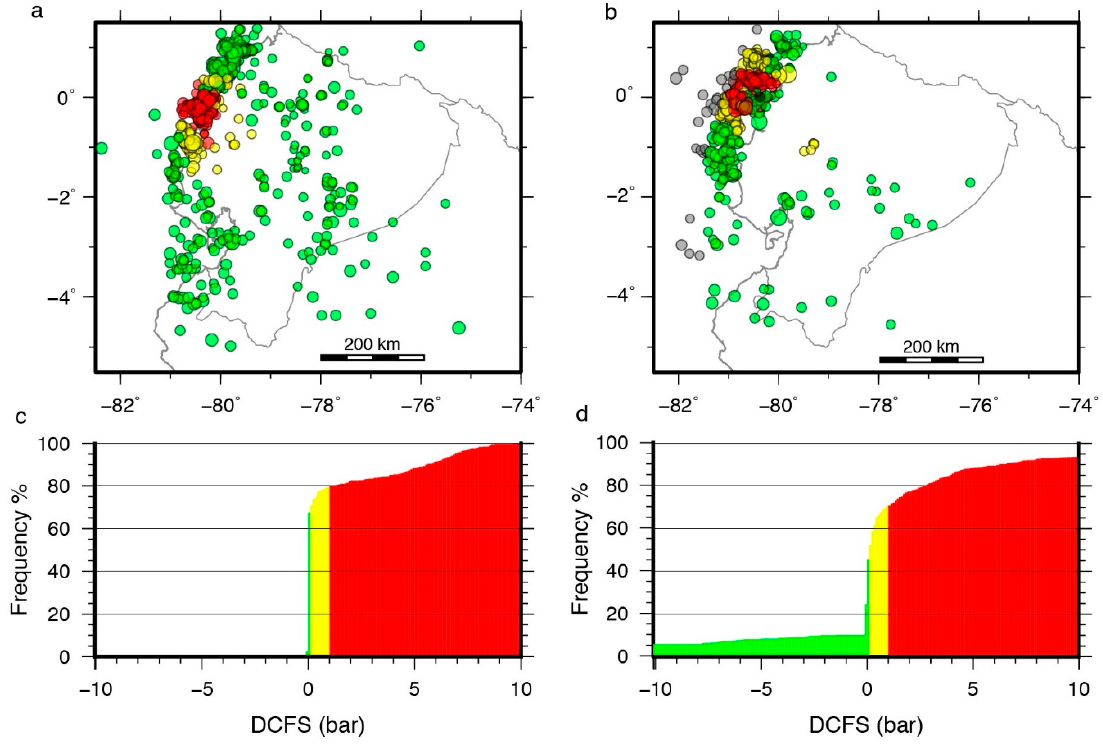
Figure 11. ( a ) Coloured circles represent seismic events in the period 16/04/2016–18/02/2018 from Instituto Geofísico Escuela Politécnica Nacional filtered for continental faults (distance to slab >10 km and depth <15 km). Colours correspond to the traffic light colour code used in Figures 7 and 8: red circles represent seismic events located in areas with a high level of potential activation ( ∆ CFS > 1 bar), yellow circles represent seismic events in medium level of potential activation (0.1 bar ≤ ∆ CFS ≤ 1), and green circles represent seismic events in areas with a low level of potential activation ( ∆ CFS < 0.1 bar; ( b ) Seismic events in the period 16/04/2016–18/02/2018 filtered for the subduction interface (distance to slab ≤ 10 km). Colours correspond to the traffic light colour code used in ( a ); ( c , d ) are the accumulated histograms of frequency (%) of seismic events after the mainshock on areas with the correspondent computed Coulomb Stress change for the continental faults ( b ) and the subduction interface ( c ). The colour of the bar indicates the level of potential activation on a traffic light colour code of Figure 8.